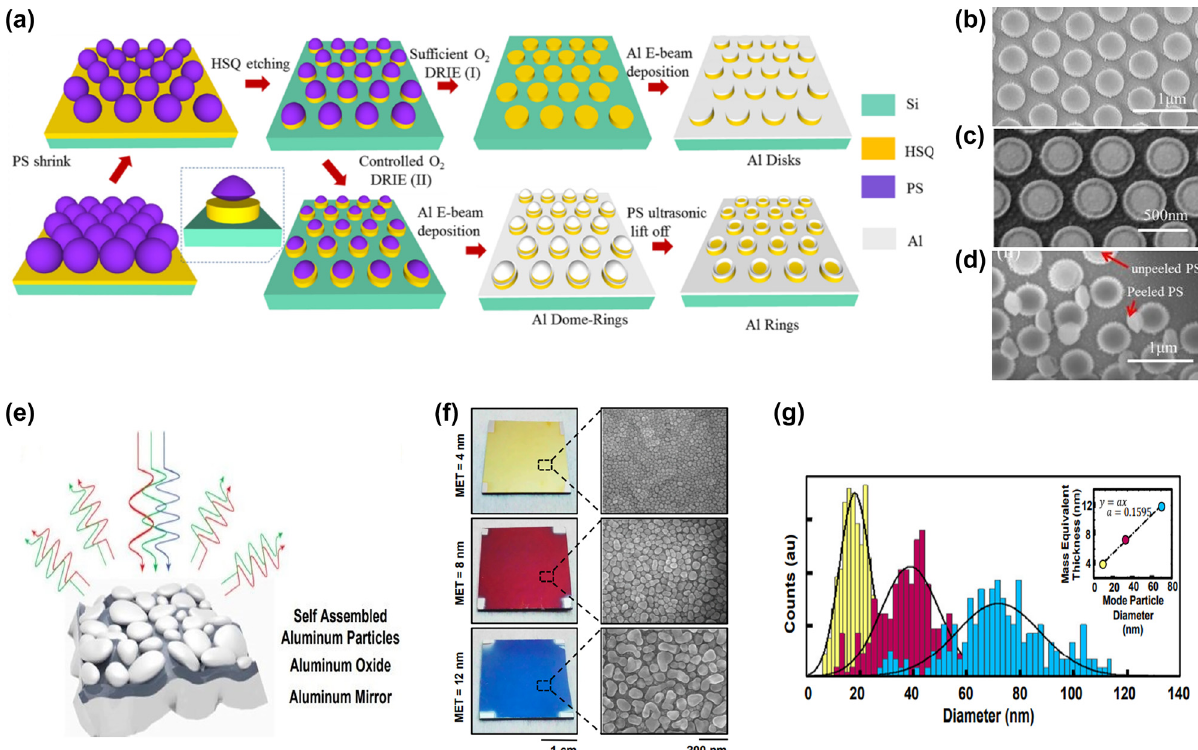
Figure 23: Self-assembly approach for fabricating subwavelength nanostructure array based structural colors. (a) Schematic flow chart for creating arrays of Al disks, dome-rings, and rings assisted by a bottom-up self-assembly process. (b)–(d) SEM images of the fabricated Al disks, dome-dings, and dings, respectively. Modified with permission [252]. Copyright 2016, American Chemical Society. (e) Schematic representation of self-assembled Al particles atop an oxide spacer and Al mirror. (f) Photos (left column) and SEM images (right column) of three samples respectively exhibiting yellow, magenta, and cyan colors. (g) Histogram of the particle sizes obtained from the fabricated samples. Reproduced with permission [253]. Copyright 2020, National Academy of